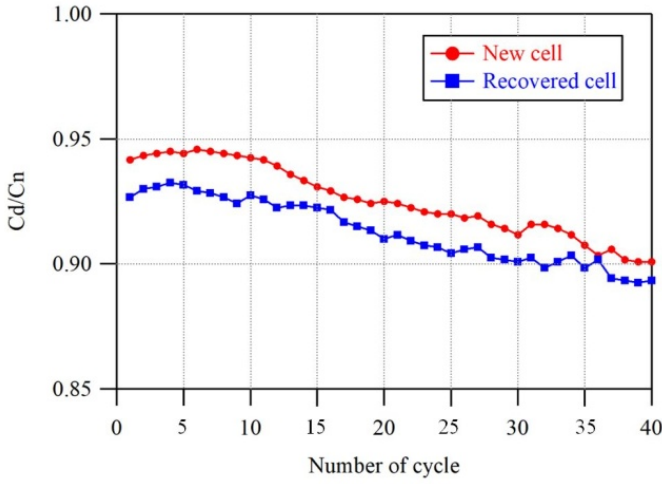
Figure 12. Discharged capacities of new cell and recovered cell during the 40 cycles of testing.